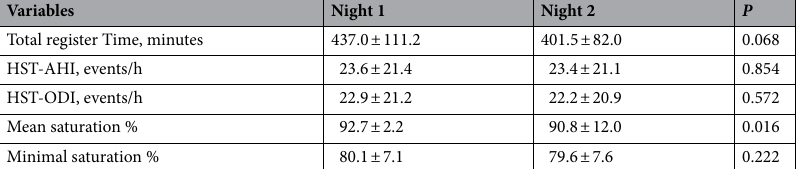
Table 2. Comparison between HST performed in two nights in 62 patients. HST home sleep test, AHI apnea– hypopnea index, ODM overnight digital monitoring, ODI oxygen desaturation index.